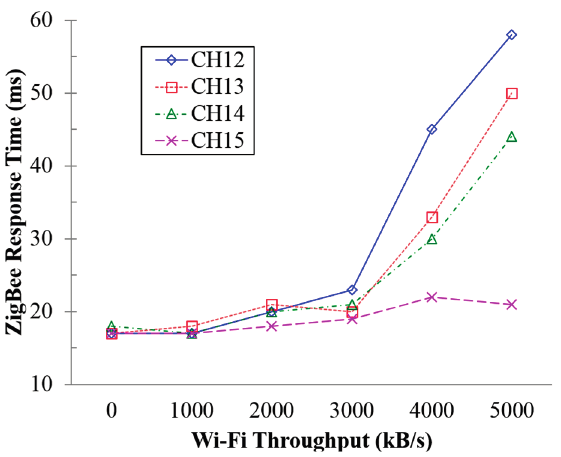
Figure 13. The impact of Wi-Fi throughputs variation on the ZigBee response